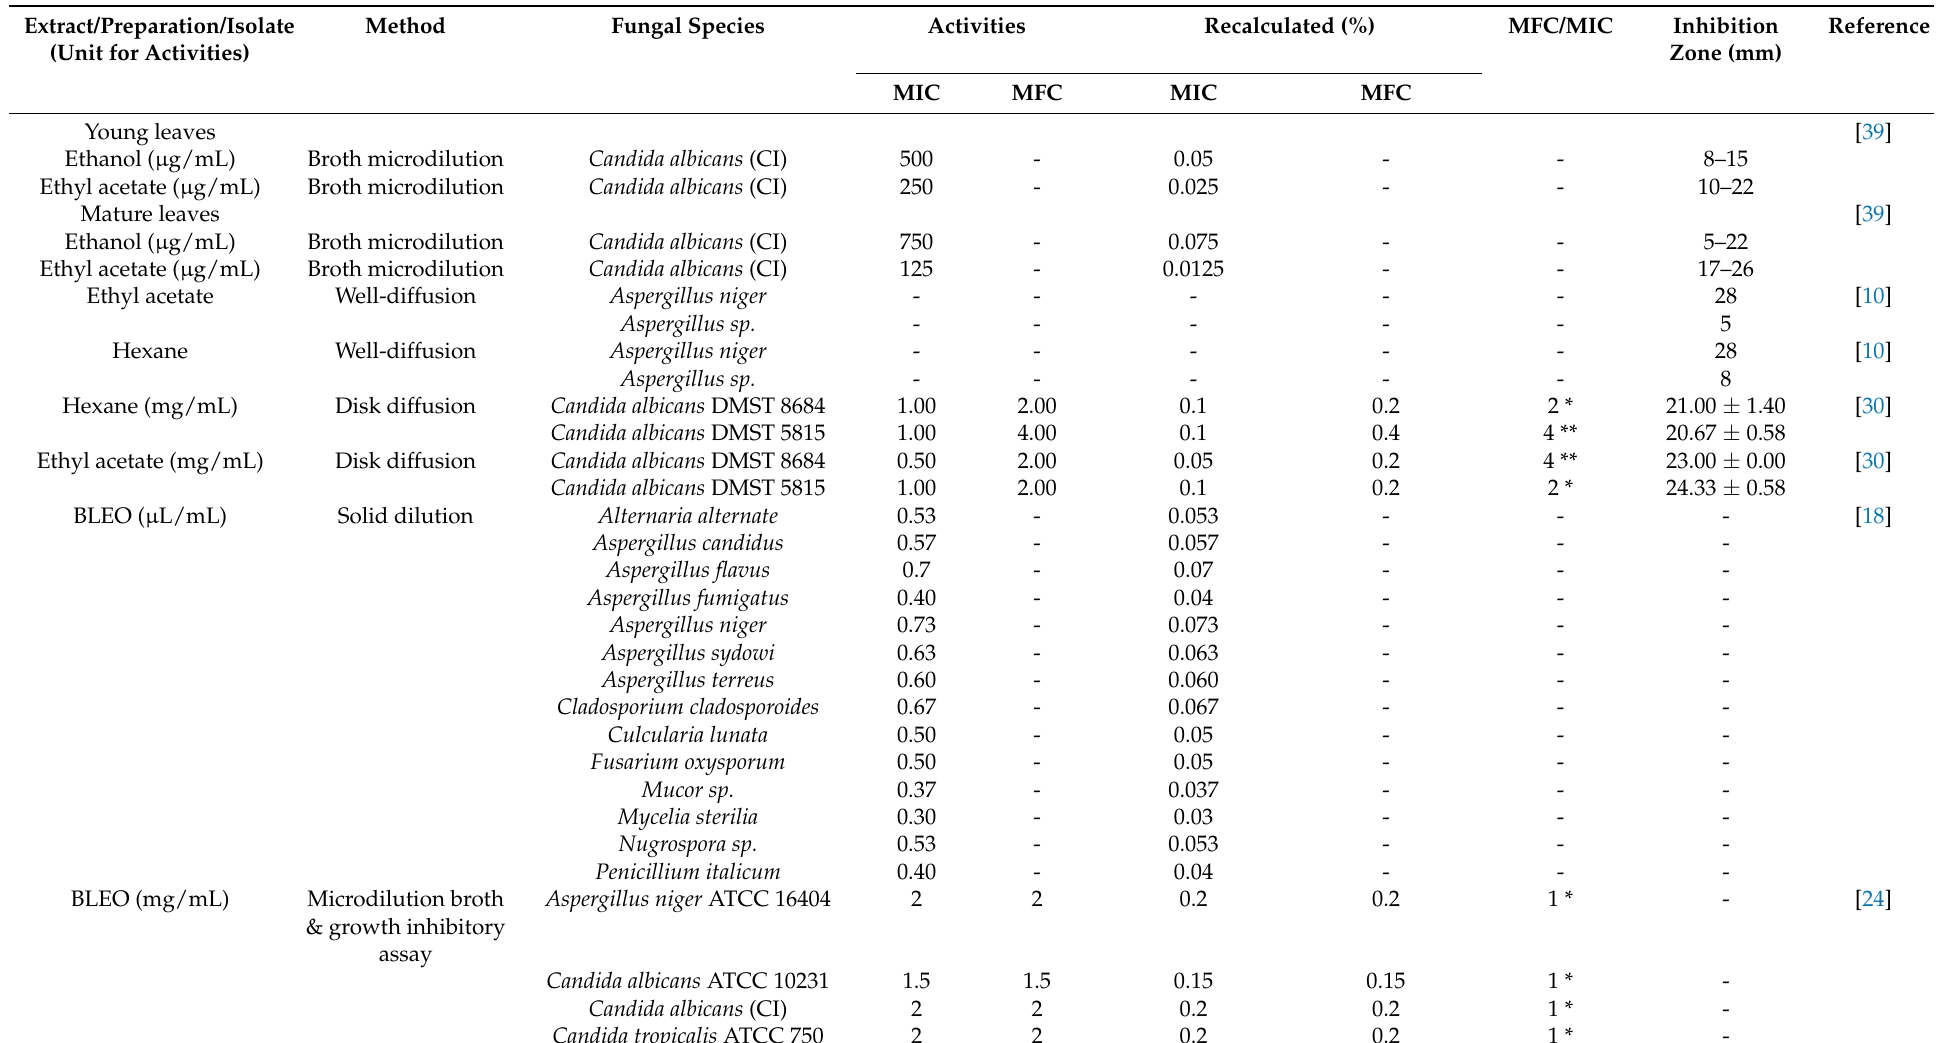
Table 4. Piper betle against various fungal